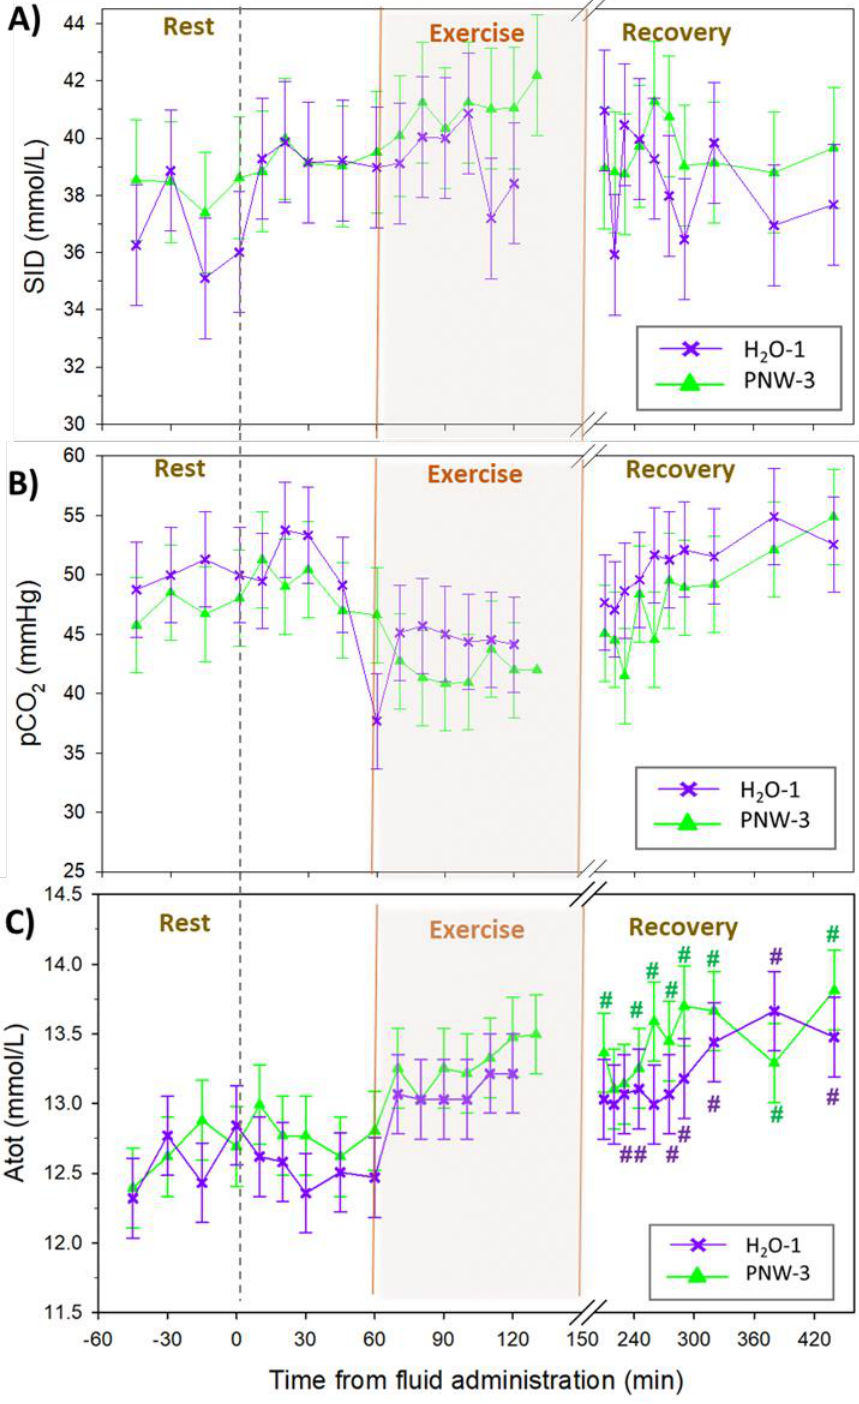
Figure 2. The time courses of plasma independent acid-base variables at rest, during prolonged submaximal exercise, and up to 4 h of recovery. ( A ) Strong Ion Difference [SID], ( B ) partial pressure of carbon dioxide [pCO 2 ], and ( C ) total weak acid concentration [Atot] for n = 4 horses. In randomized crossover design horses were administered either 3 L of a balanced hypotonic oral electrolyte solution (PNW-3), or 1L of water alone (H 2 O-1), 60 min before they exercised on a treadmill at 30% of peak VO 2 until voluntary fatigue. Values are mean ± SE. There were no significant differences between groups. # indicates significantly ( p < 0.05) increased compared to pre-exercise.